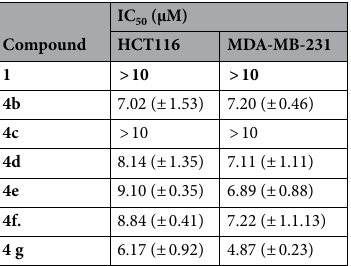
Table 1. The IC 50 values of luteolin and 5- O -acyl luteolin derivatives against the two cancer cell lines.